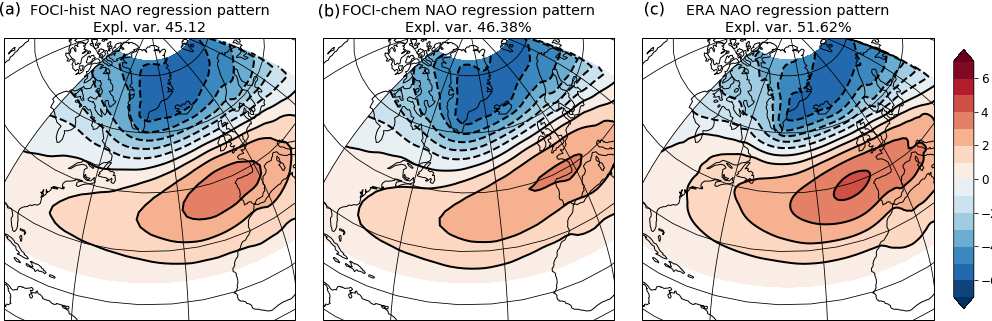
Figure 17. Ensemble mean NAO regression pattern from (a) FOCI-hist, (b) FOCI-chem and (c) ERA-Interim for the period 1960–2013.